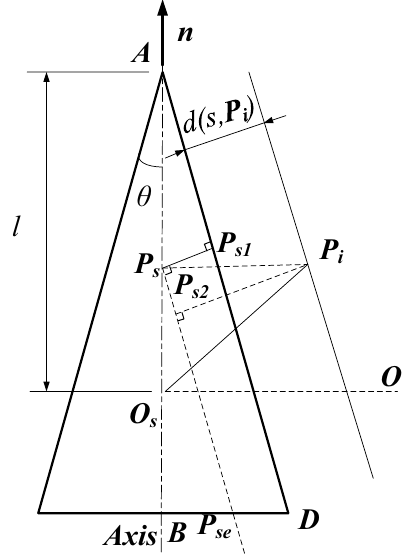
Figure 5. Distance function model of conical